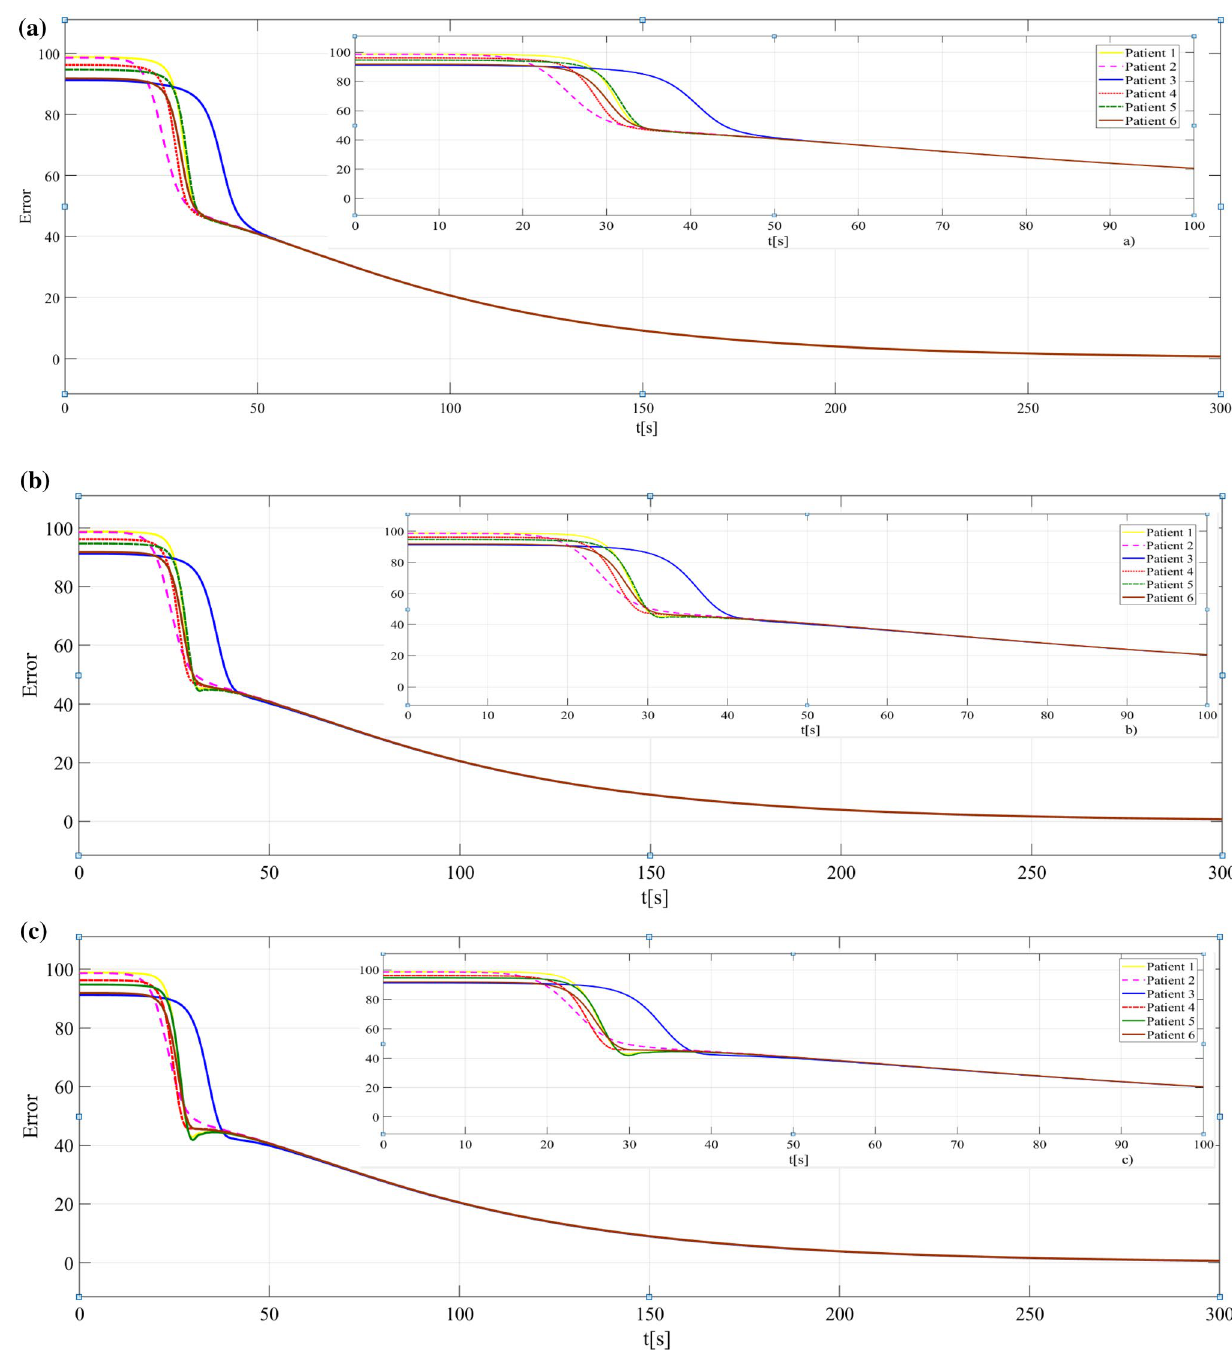
Fig. 7 The error (PI λ controller) a α = 0.5; b α = 0.75; c α =